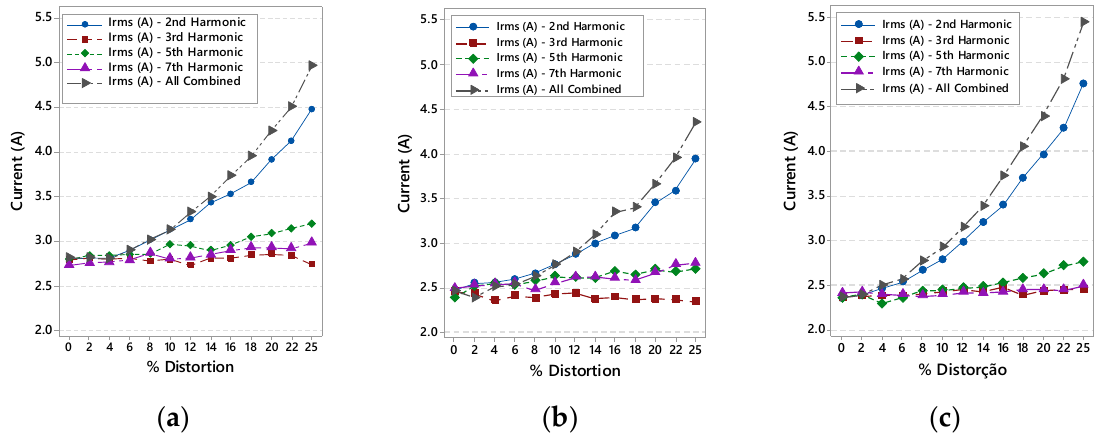
Figure 7. Current increase for 2nd, 3rd, 5th, 7th and all harmonic order combined for induction motors ( a ) IE2 SCIM; ( b ) IE3 SCIM; ( c ) IE4 LSPMM.